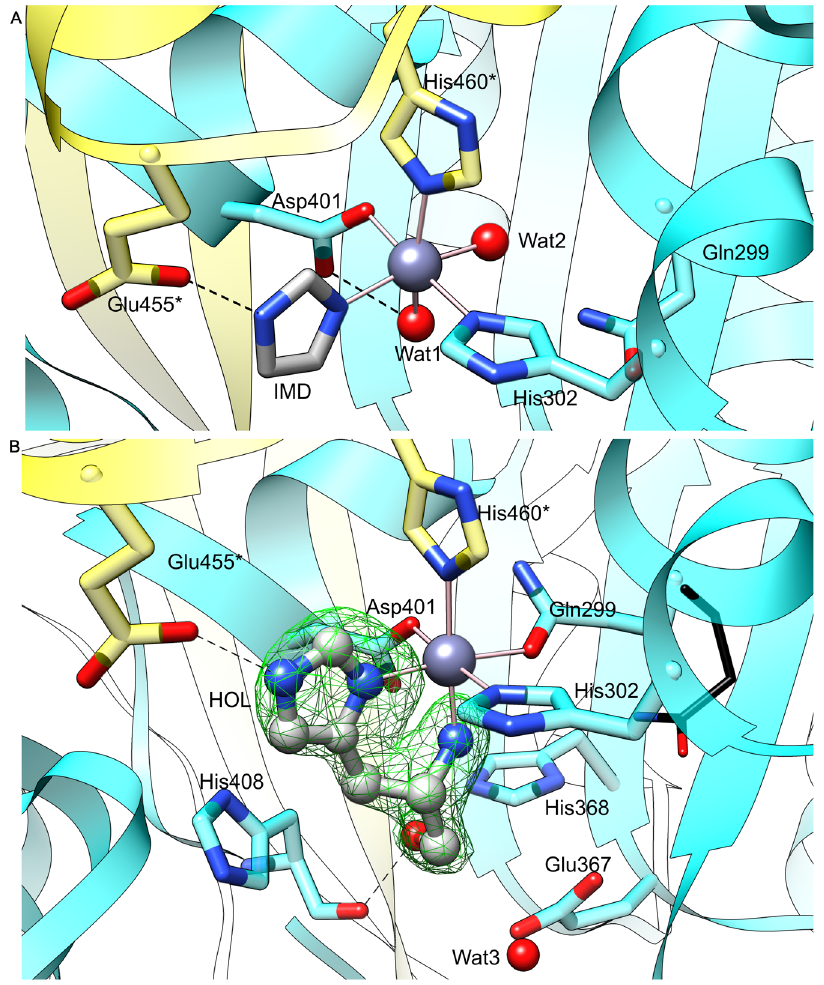
Figure 4. The active site of Mt HDH. Chain A is coloured cyan whereas chain B is yellow. Zn 2 + coordination and imidazole (IMD) binding is shown in the A panel. The panel B depicts binding of the substrate, histidinol (HOL, ball-and-stick, green mesh is the omit F o − F c electron density map, contoured at 7 σ level). Gln299 from superposed Mt HDH/IMD on Mt HDH/HOL complex is shown as thin black sticks in the panel B for